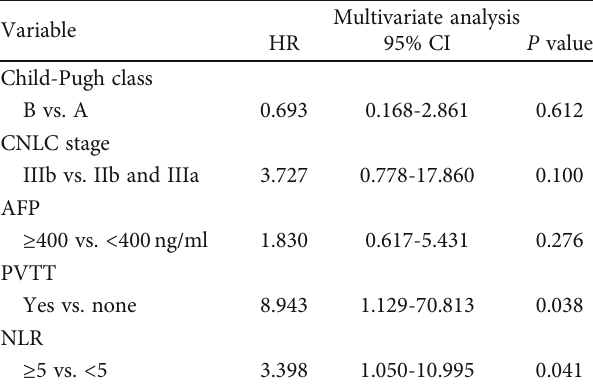
Table 8: Multivariate Cox proportional hazards regression models for overall